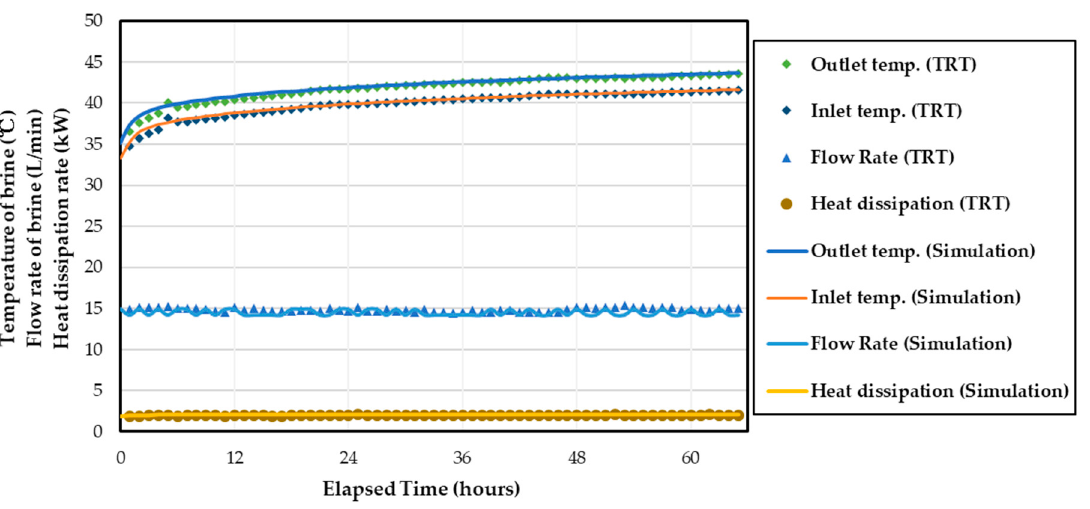
Figure 5. Thermal response test (TRT) history matching results.